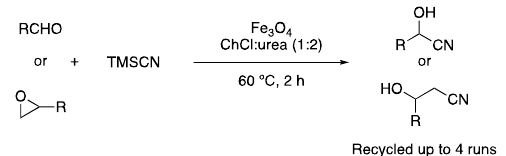
Figure 40. Cyanosilylation of aldehydes and epoxides.